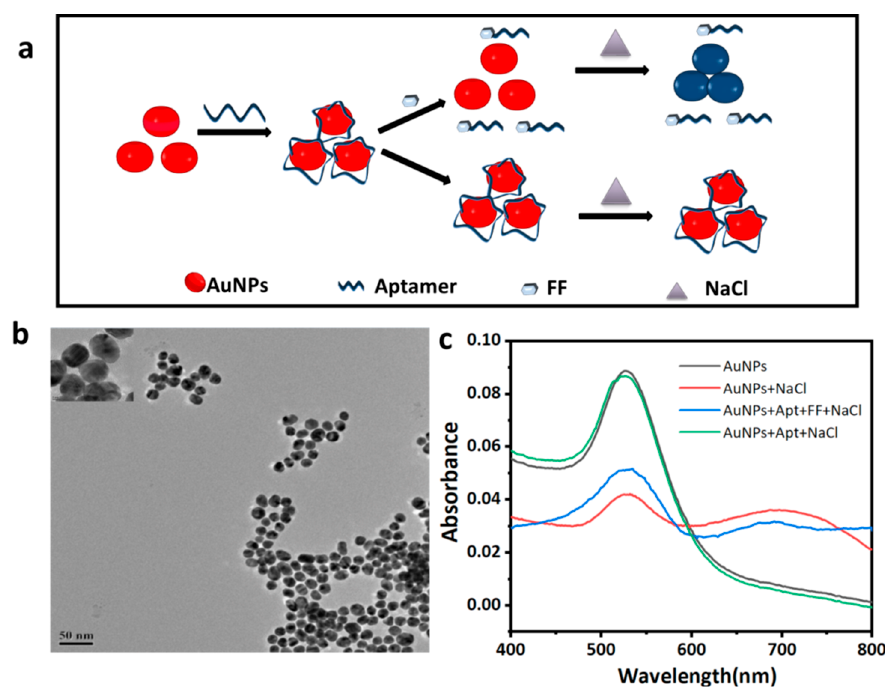
Figure 3. ( a ) Schematic diagram of the aptamer and nanogold assay FF. ( b ) Transmission electron microscope scan of AuNPs. ( c ) UV—vis absorption spectra of different systems.